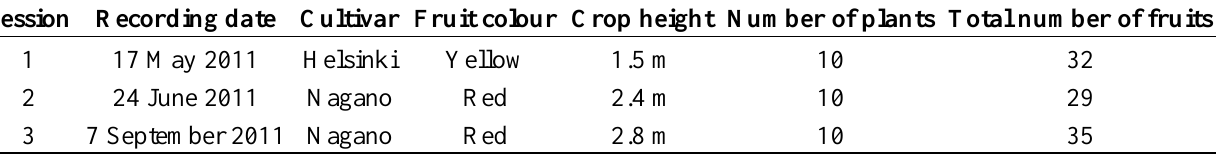
Table 1. Crop characteristics during the